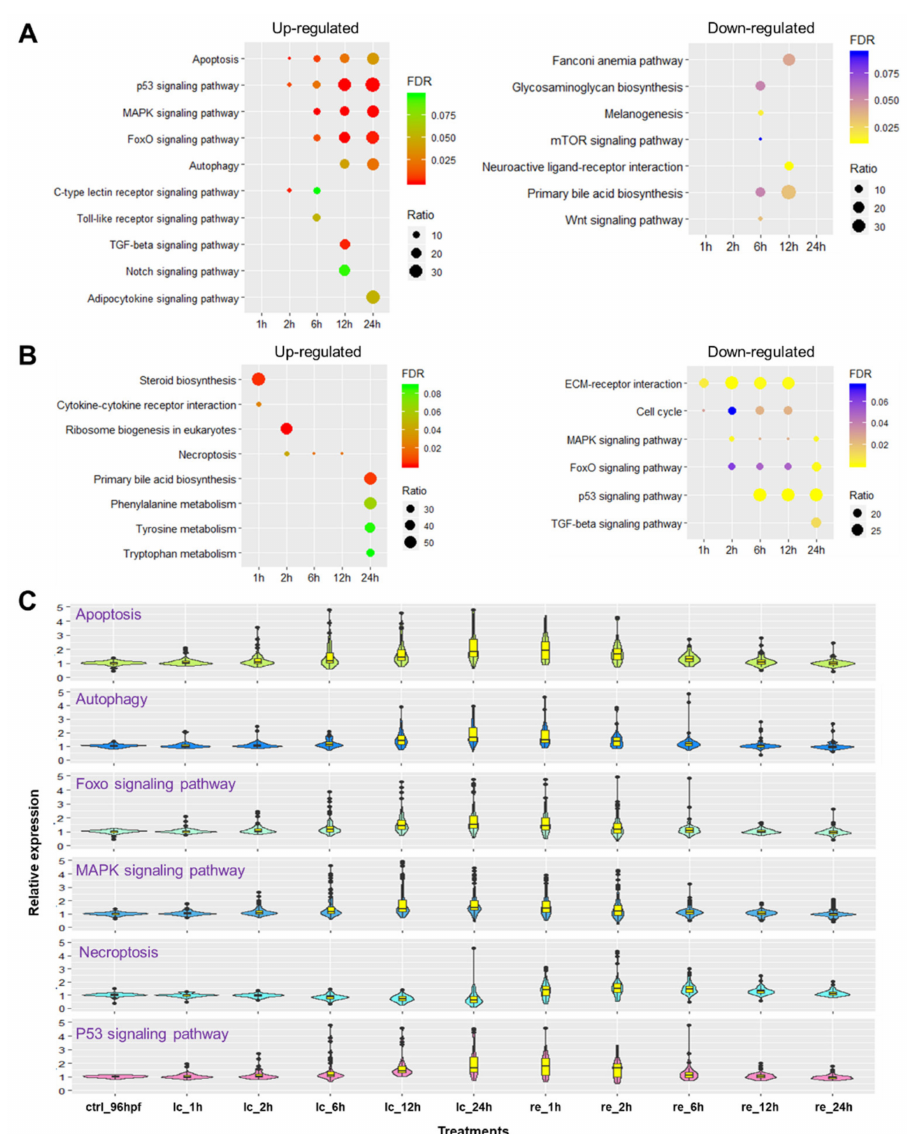
Figure 5. Kyoto encyclopedia of genes and genomes (KEGG) pathway enrichments for the genes differentially expressed upon cold stress and subsequent rewarming. ( A , B ) Bubble plots indicate the enriched KEGG pathways for the up- (left panel) and down-regulated (right panel) genes. The DEGs at different time points under lethal cold stress ( A ) and during recovery ( B ) were used for analysis. The pathway terms are shown on the left. Figure legends including FDR and ratio (percent of the identified genes to all the genes in a certain pathway) are shown on the right. ( C ) Violin plots demonstrate the relative expression abundance of genes associated with the identified pathways. Expression of the genes was normalized to the average level of the untreated controls at 96 hpf